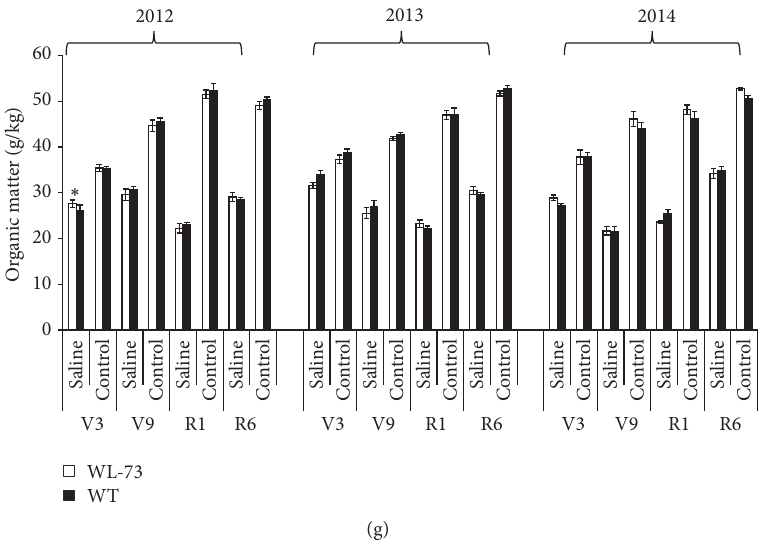
Figure 6: Assays of seven physicochemical properties of rhizosphere soil. BcWRKY1 transgenic maize (WL-73) and nontransgenic maize (WT; LH1037) plants were grown in saline or control nonsaline soil from 2012 to 2014. Seven physicochemical parameters were measured, and a statistical analysis was performed using the LSD test with 𝑃 < 0.05 and 𝑛 = 3 . (a) pH; (b) SAR value; (c) electrical conductivity; (d) available N; (e) available K; (f) available P; (g) organic matter. WT, wild-type maize LH1037; WL-73, LH1037 plant transformed with BcWRKY1 ; V3, the three lowest leaves have a visible collar; V9, nine leaves have collars present; R1, silking; R6, physiological maturity. ∗ indicates a significant difference at 𝑃 < 0.05 according to the LSD test ( 𝑛 = 3 ). ∗∗ indicates a significant difference at 𝑃 < 0.01 according to the LSD test ( 𝑛 = 3 ). The standard error is based on the average of three biological replicates. Note: no overall significant differences were observed between WL-73 and WT plants for most of the physicochemical properties ( 𝑃 > 0.05 ) at four maize growth periods (R1, R9, V1, and V6) in saline and control soil environments from 2012 to